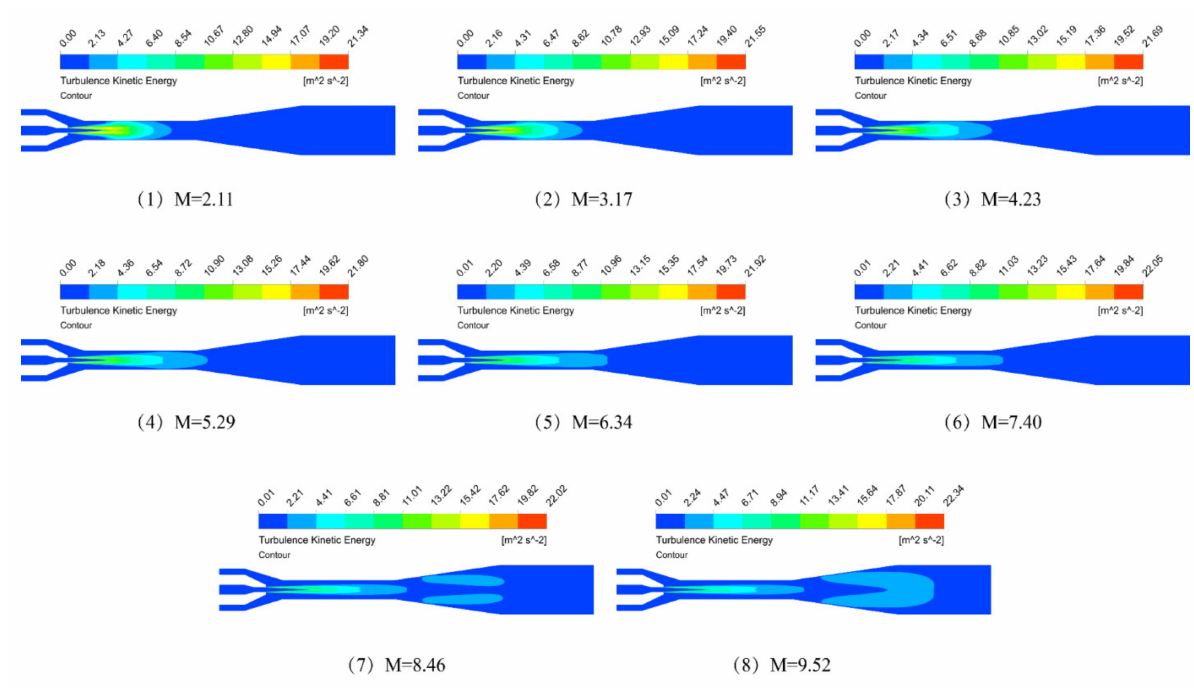
Figure 6. Turbulent kinetic energy distribution of lengthwise section ( M = 2.11, 3.17, 4.23, 5.29, 6.34, 7.40, 8.46, 9.52).